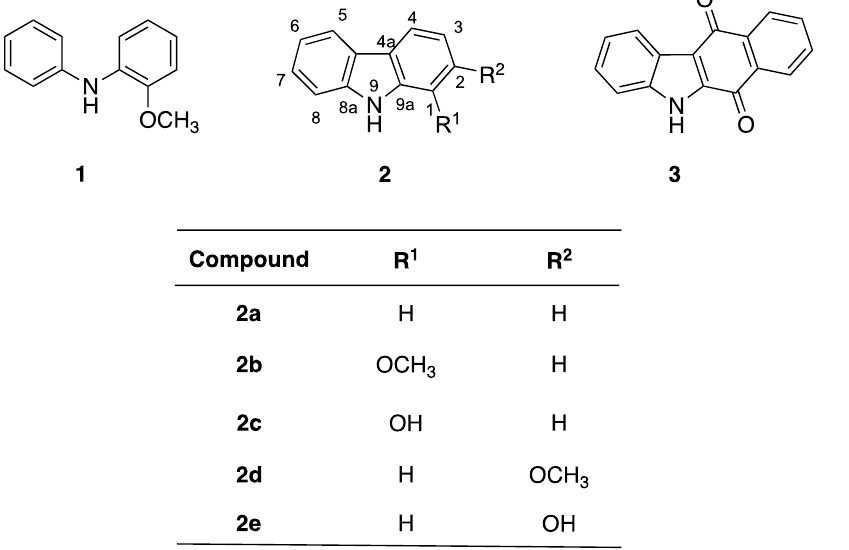
Figure 1. Chemical structures of the carbazole derivatives assayed as potential fluorescence sensors.